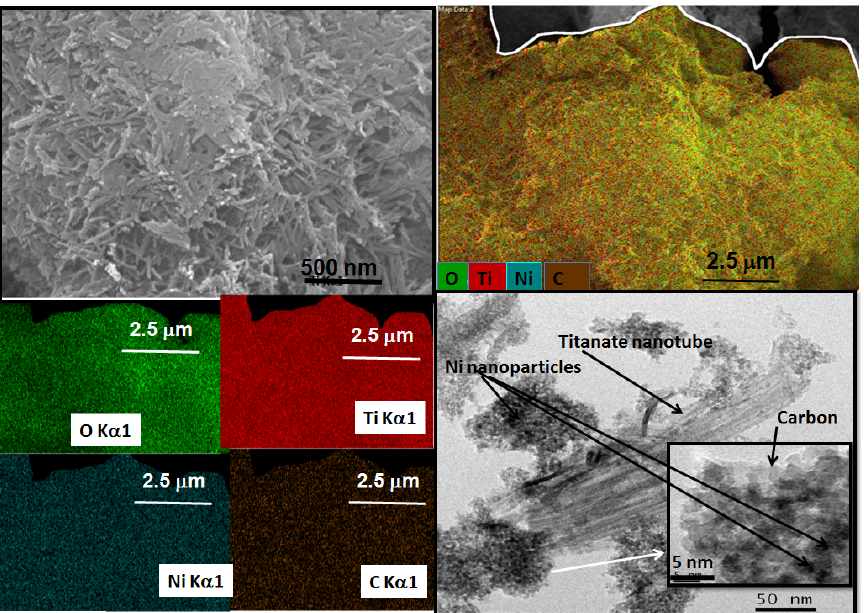
Figure 10. SEM-EDS and TEM images of NiNT spent titanate nanotubes catalyst characterizations. Reaction conditions: amount of the catalyst, 0.15 g; reaction gas mixture, 500 ppm of NO, 1000 ppm of CO and balance in He; flow rate, 80 mL·min − 1 ; space velocity, 48,000 h − 1 . Either 10 wt% (v/v) of water vapor or 50 ppm of SO 2 (or both) was used during the reaction at 250 °C for 6 h.